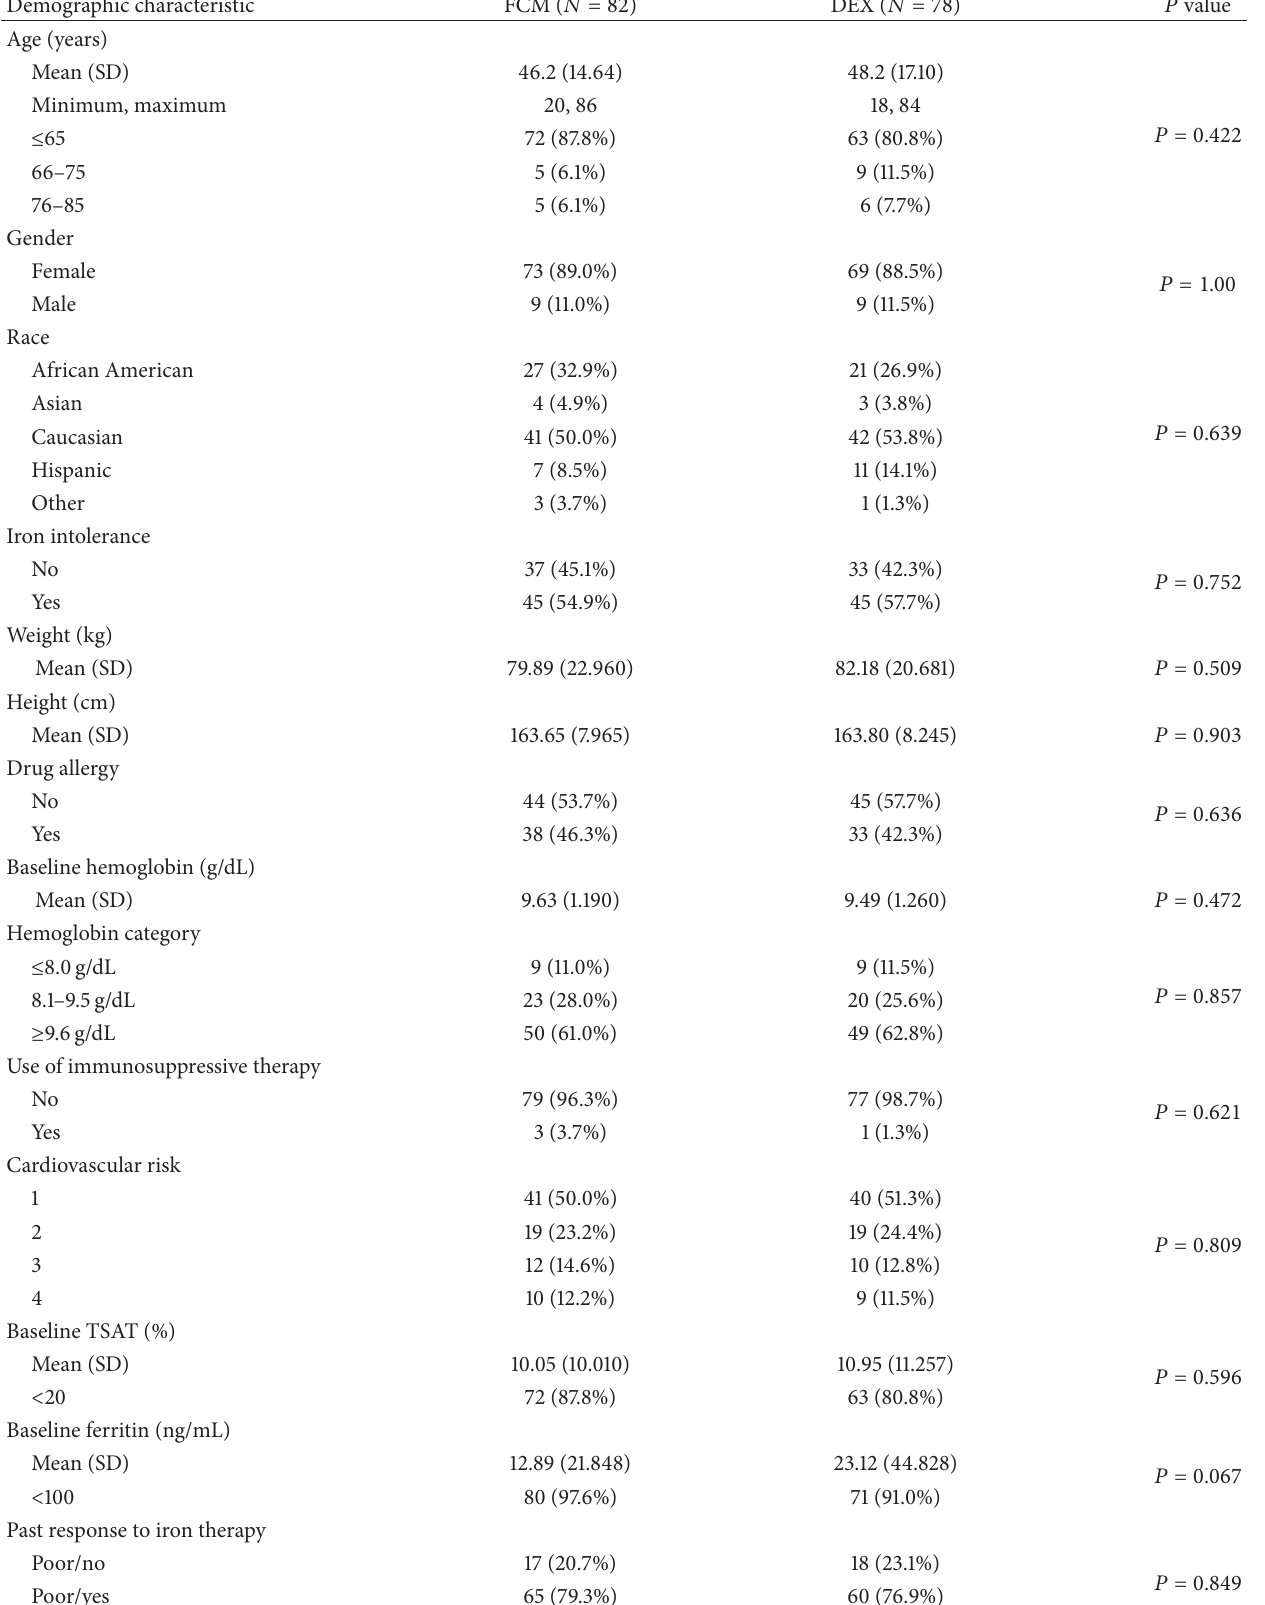
Table 1: Baseline demographics and